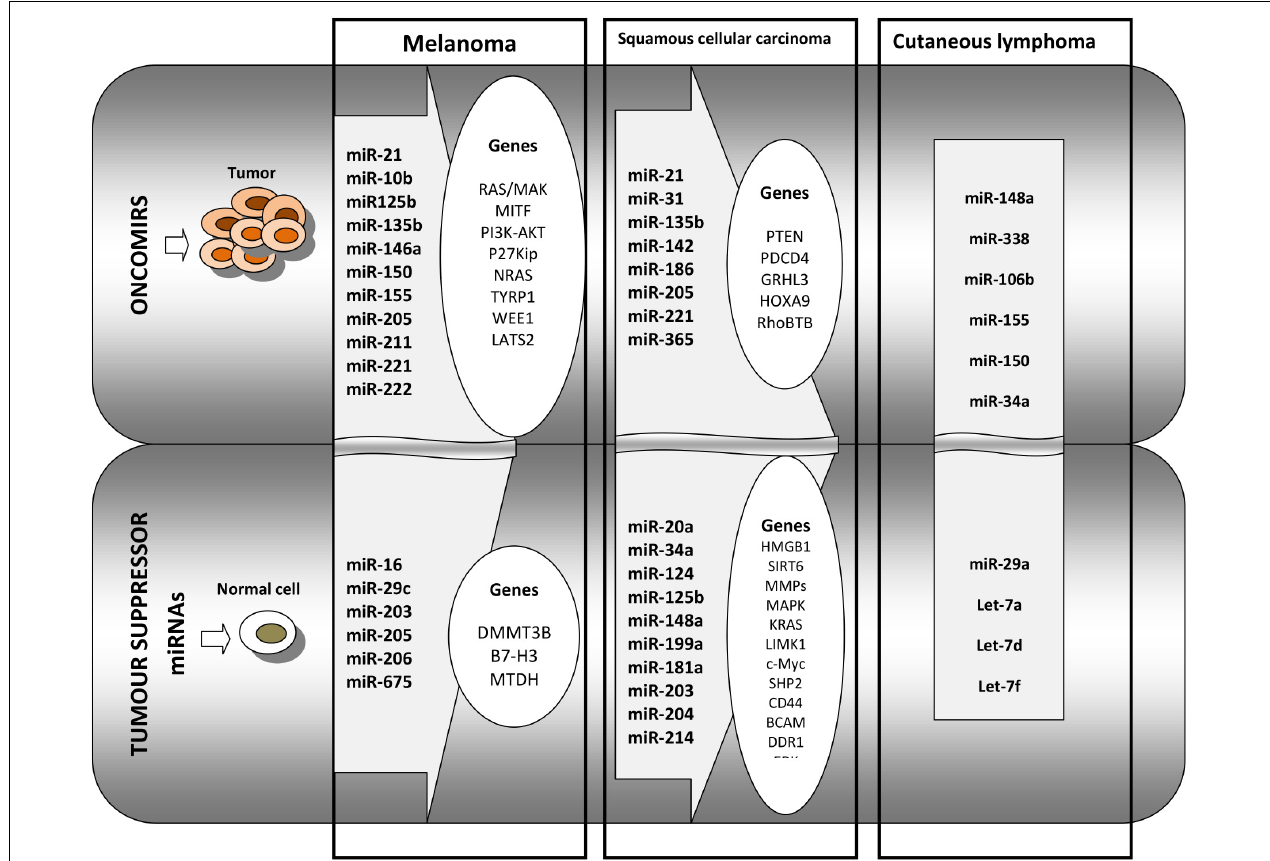
FIGURE 2 | Overview of the main miRNAs and the regulated genes that are identified in melanoma, in squamous cell carcinoma, and in cutaneous lymphoma. The first panel of oncomirs represents the miRNAs that regulate pro-tumoral genes in melanoma, squamous cell carcinoma, and in cutaneous lymphoma. The second panel represents tumor suppressor miRNAs regulating genes that are involved in anti-tumoral processes in squamous cell carcinoma and in cutaneous lymphoma.